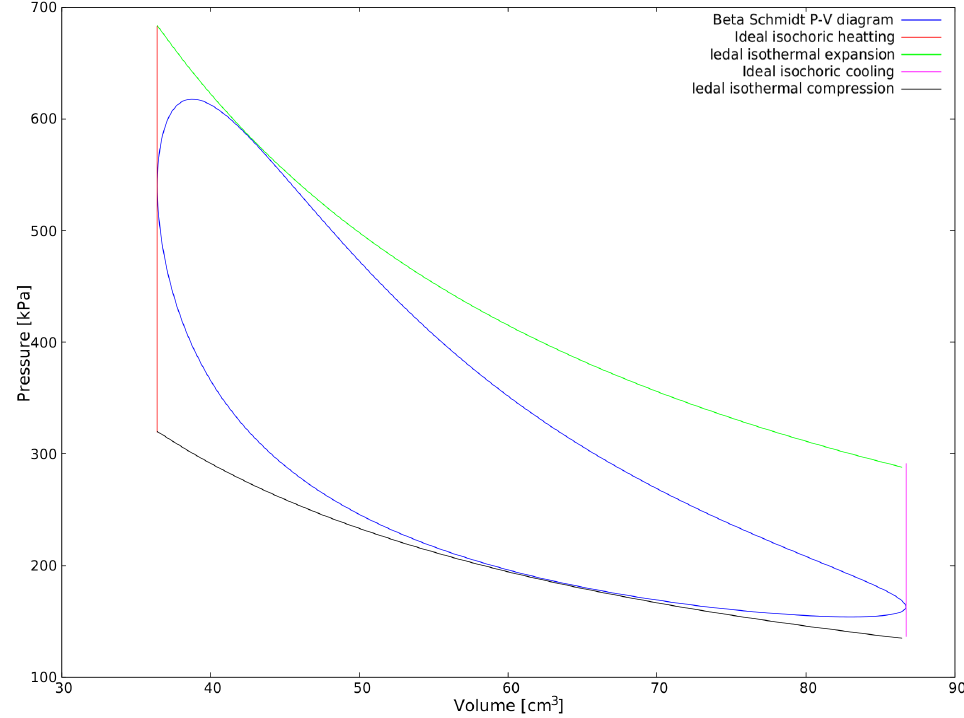
Figure 10. Beta with crank P-V